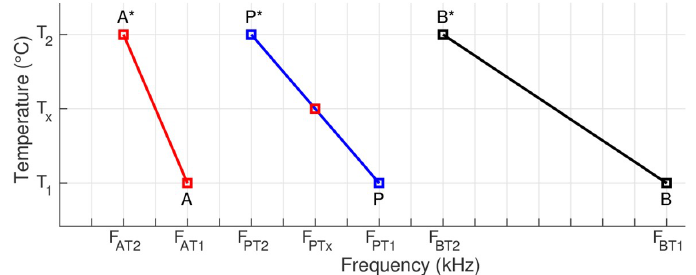
Figure 11. Geometric representation of frequency shifts.